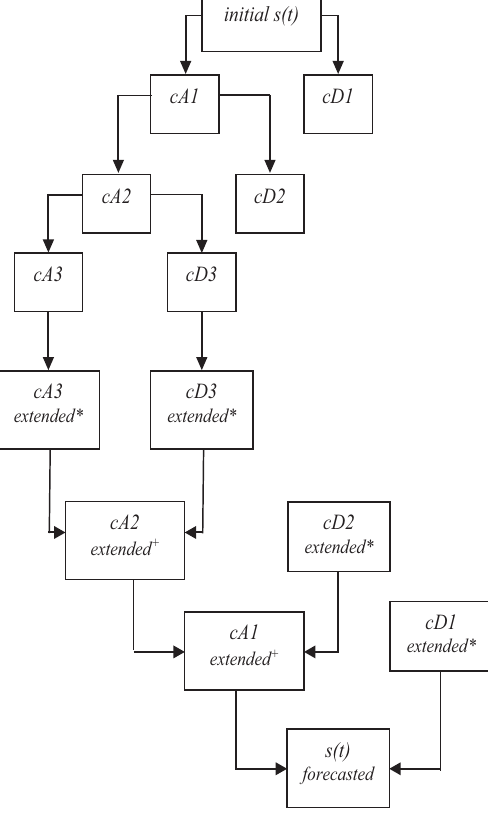
Figure 5. Diagram of a 3rd- level wavelet decomposition/ reconstruction tree to forecast the initial signal s